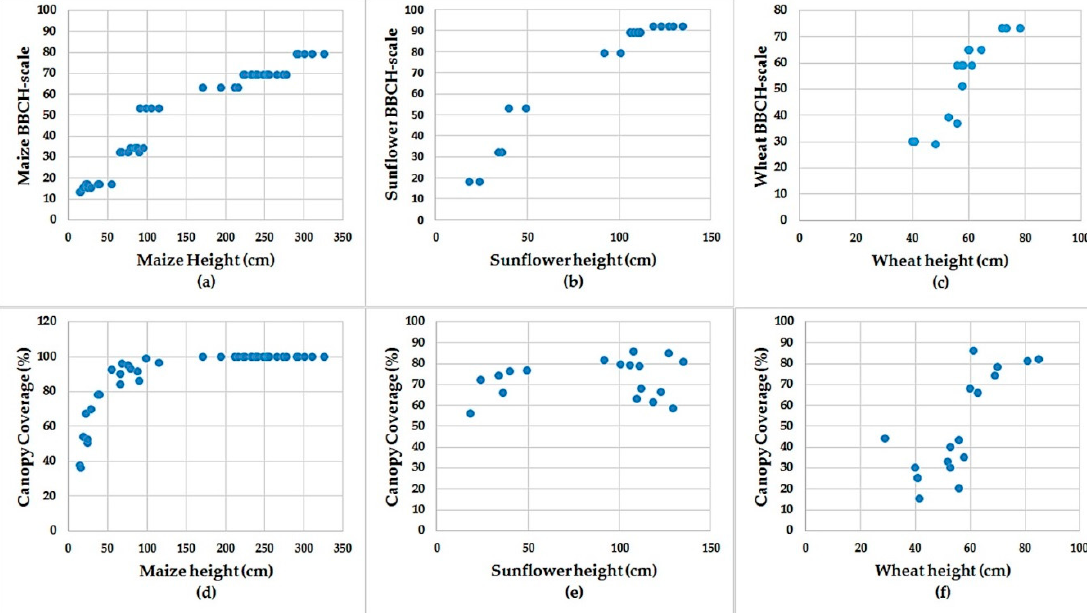
Figure 6. BBCH ‐ scale relationship with crop height ( a–c ), and Correlation between canopy coverage Figure 6. BBCH-scale relationship with crop height ( a – c ), and Correlation between canopy coverage (CC) and crop height ( d–f ) for maize, sunflower , and wheat. (CC) and crop height ( d – f ) for maize, sunflower, and